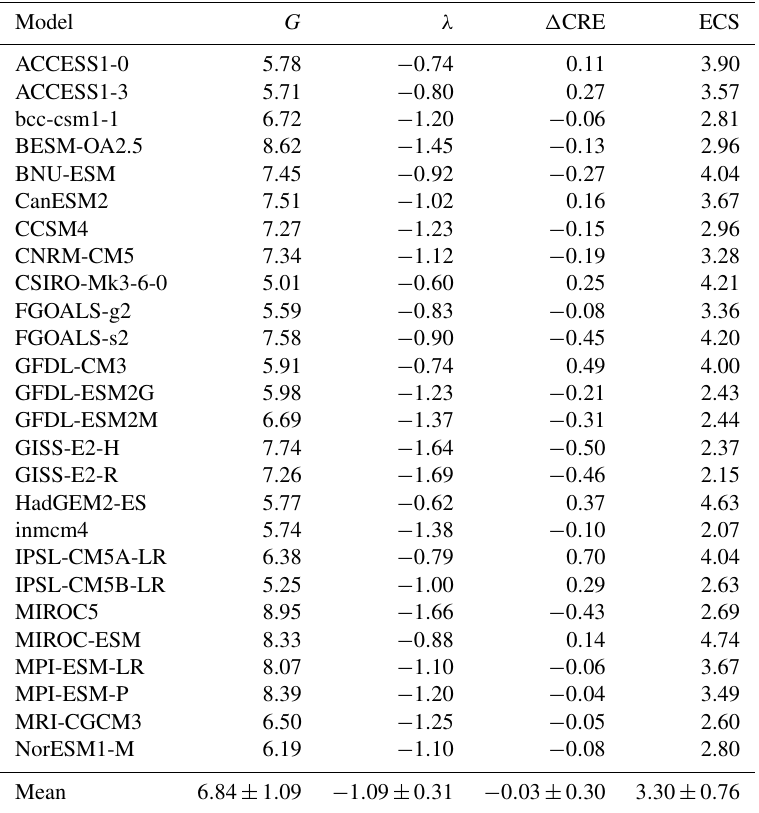
Table 3. CO 2 forcing (Wm − 2 ) ( G ), net feedback (Wm − 2 K − 1 ) ( λ ), climate response (Wm − 2 ) ( (cid:49) CRE), and equilibrium climate sensitivity (K) (ECS)